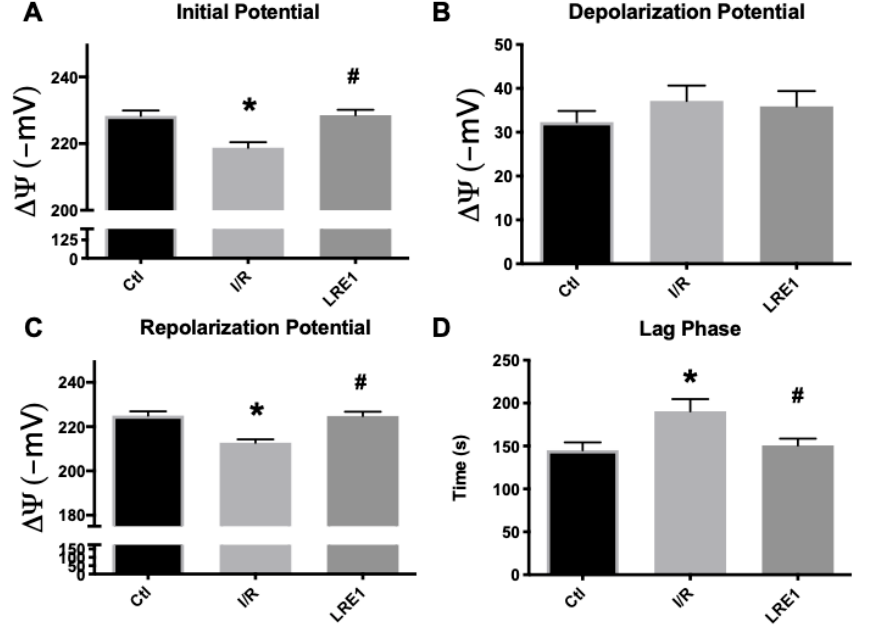
Figure 1. Mitochondrial membrane initial potential ( A ), ADP-driven depolarization potential ( B ), repolarization potential ( C ) and lag phase time ( D ) as evaluated by tetraphenylphosphonium ion (TPP + ) fluctuations and recorded with a TPP + -sensitive electrode. Data are means ± SEM of 4 independent experiments. * indicates a statistically significant difference vs. sham operated controls (Ctl); # indicates a statistically significant difference vs. ischemia/reperfusion (I/R).